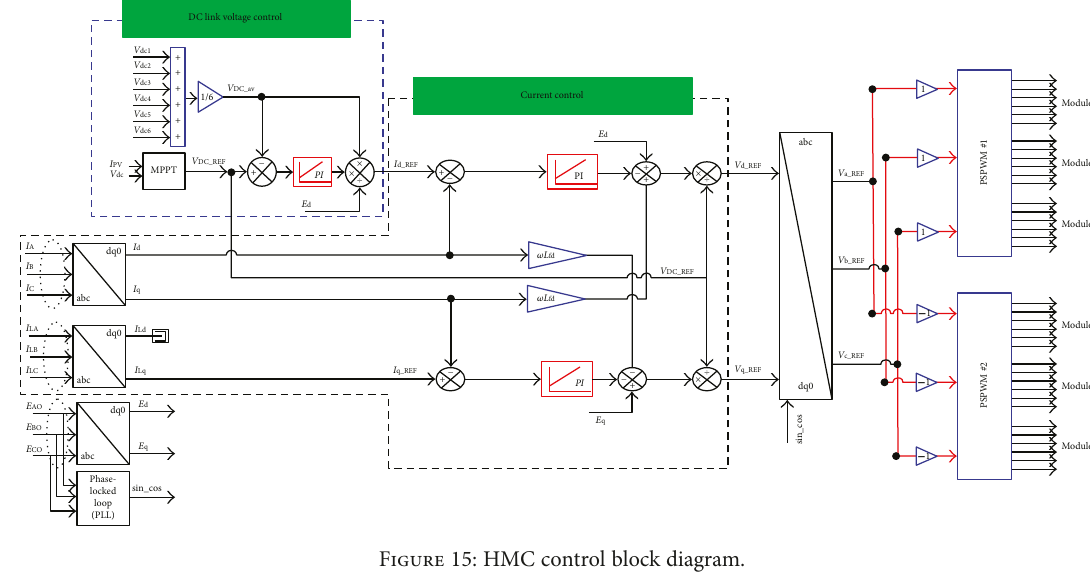
Figure 15: HMC control block